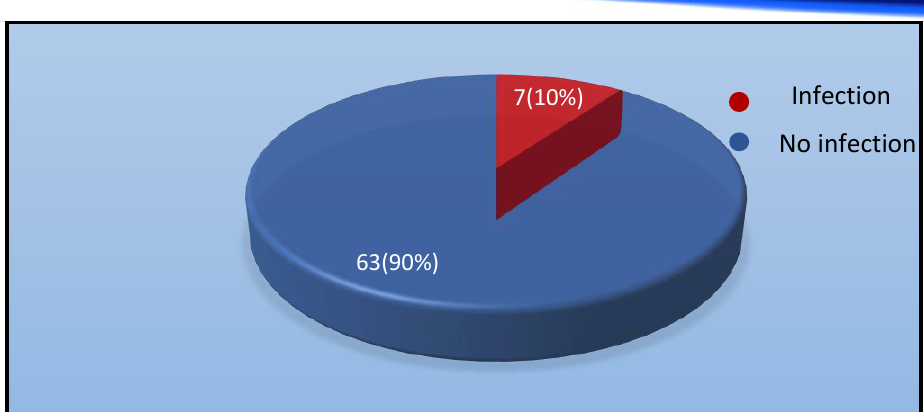
Fig.(1): Distribution of study patients by postoperative infection.